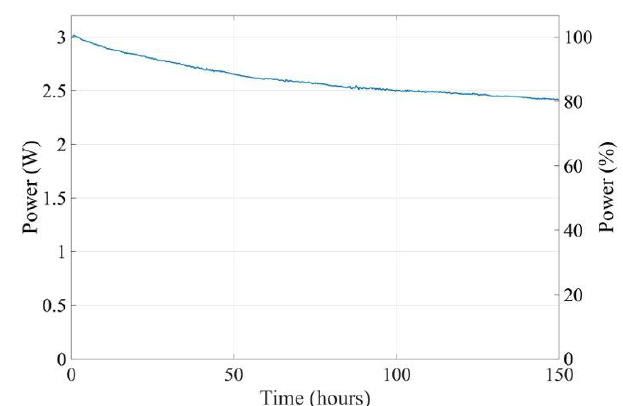
Figure 4. Measured output power of the MOPA using fiber I showing a slow decrease over time as a result of residual photodarkening loss.